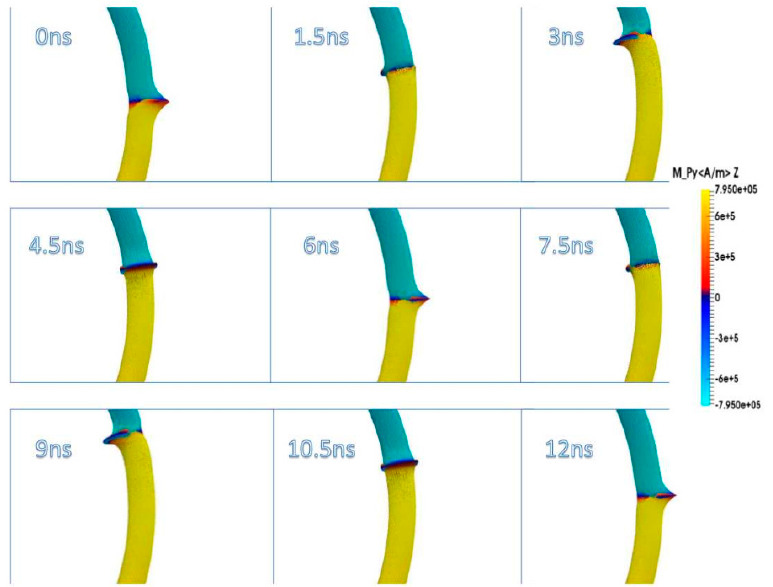
Figure 6. Time-dependent domain wall oscillations in a curved nanowire. Reprinted with permission from [57]. Copyright (2017) by the American Physical Society.